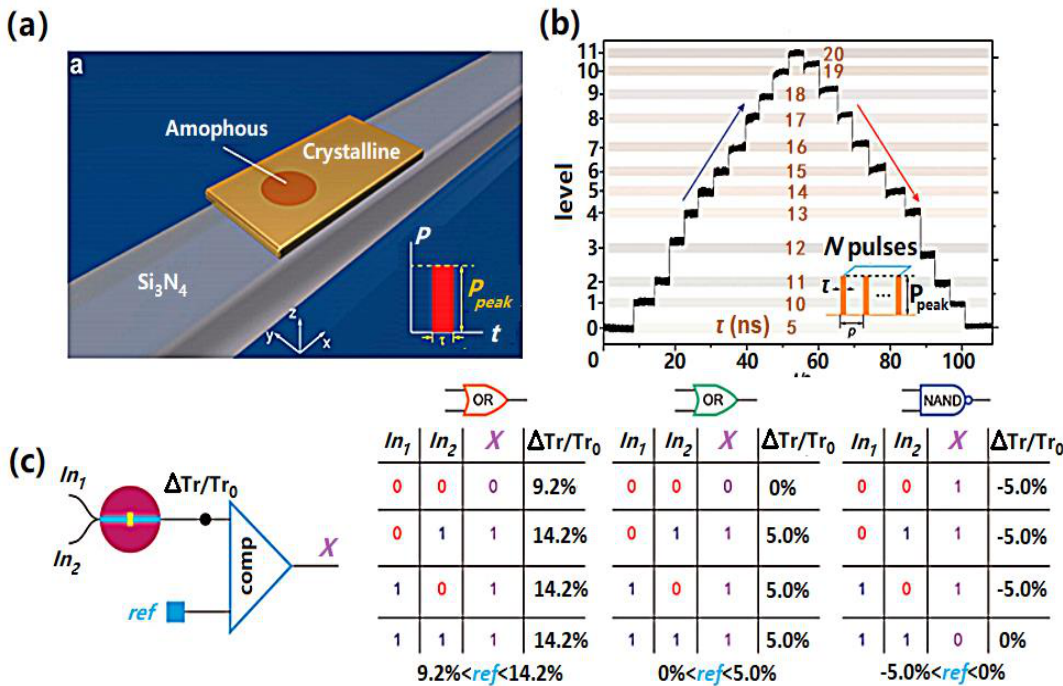
Figure 13. Photonic-based PCRAM: ( a ) an all-photonic memory structure; ( b ) the resulting transmission levels when adjusting the intensity and the width of the optical pulse; ( c ) schematic of the optical logic device and its corresponding ‘truth’ table. (Reprinted with permission from [1 31].)